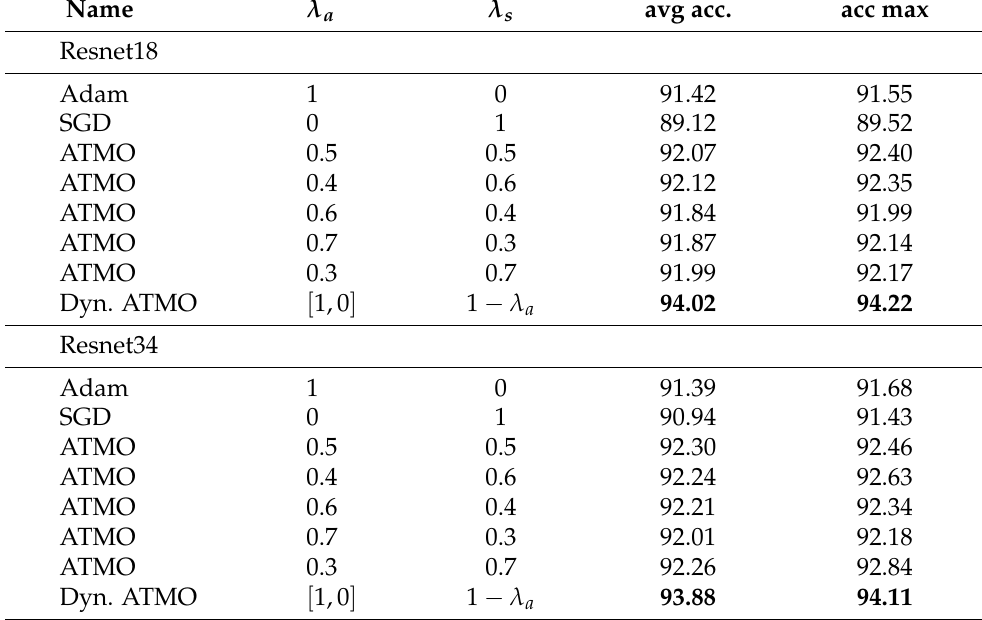
Table 2. Mean accuracies (avg. acc) and maximum accuracies (acc max) in percentage on Cifar10, after 7 runs and 350 epochs for each run. Dyn. ATMO shows the accuracies obtained with the use of dynamic lambdas.